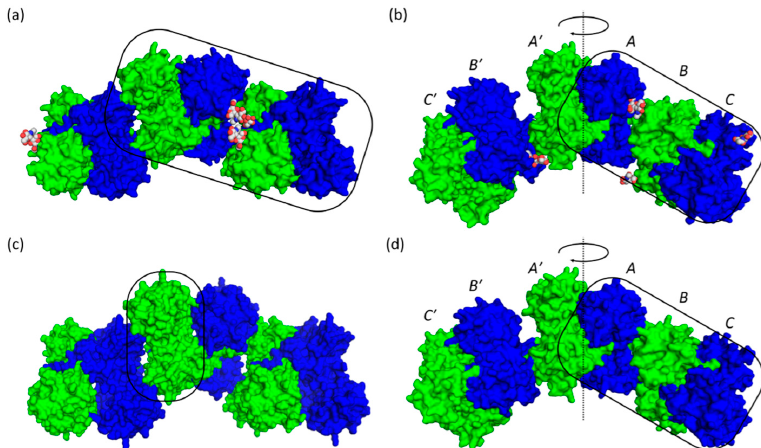
Figure 4. Lattice packing of ( a ) low-Ca 2+ native bovine Casq1; ( b ) high-Ca 2+ native bovine Casq1; ( c ) low-Ca 2+ recombinant bovine Casq1 and ( d ) high-Ca 2+ recombinant bovine Casq1. The pillboxes are approximate representations of the crystallographic asymmetric units. The positions of monomers A, B and C in the high-Ca 2+ hexamers are labeled, along with their symmetry equivalents A ′ , B ′ and C ′ , which are related by a two-fold rotation axis perpendicular to the long polymer axis, represented here as a dotted line and clockwise arrow within the front-to-front intermolecular interface formed between monomers A and A ′ . Individual Casq1 molecules were depicted with alternating colors of blue and green for easy view. The glycan moieties upon posttranslational modification were represented by the CPK model of grey (carbon atoms) and red (oxygen atoms) colors. To identify any possible glycosylation-dependent structural differences between native and recombinant calsequestrin, we superposed the C α positions of Pro7 through Pro334 (i.e., Domains I to III, shown in Figure 3 (Figure 5 and Table 1).